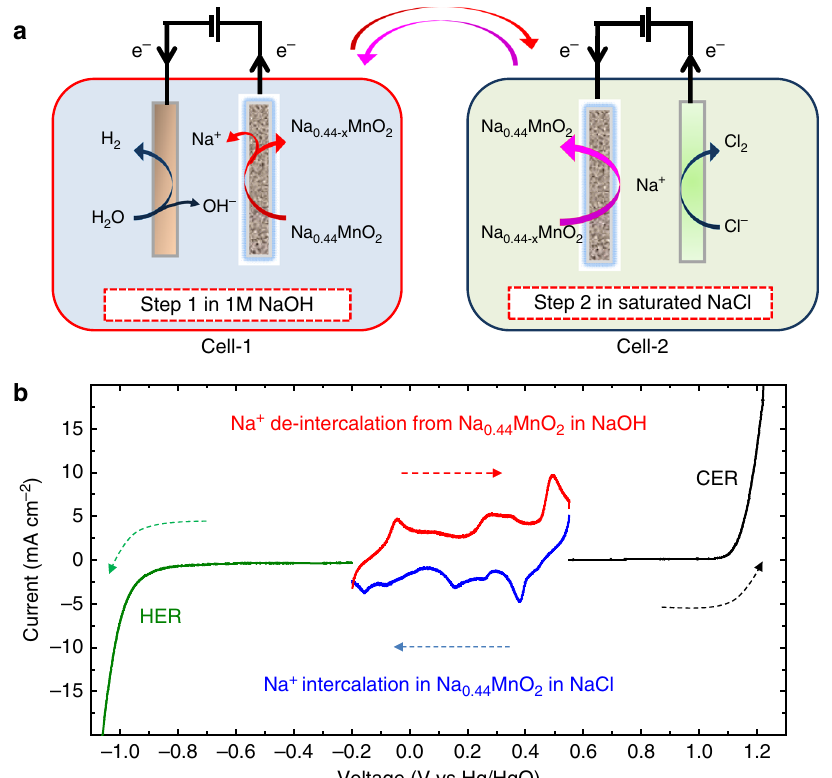
Fig. 1 Mechanism of two-step chlor-alkali electrolysis. a Schematic illustration of the operation mechanism of the electrolysis cell. Step 1 involves the cathodic reduction of H 2 O on the HER electrode and anodic Na + de-intercalation from the Na 0.44 MnO 2 electrode in an NaOH solution (Cell 1); Step 2 depends on the cathodic Na + intercalation on the Na 0.44 − x MnO 2 electrode and anodic Cl 2 evolution reaction on the CER electrode in a saturated NaCl solution (Cell 2). b Linear sweep voltammetric (LSV) data at a sweep rate of 2 mV s − 1 of Na + de-intercalation from Na 0.44 MnO 2 in 1 M NaOH (red line) and Na + intercalation in Na 0.44 − x MnO 2 in a saturated NaCl solution (blue line); LSV data of the commercial Pt-coated Ti-mesh electrode for HER at a sweep rate of 2 mV s − 1 in 1 M NaOH solution (green line); LSV data of commercial RuO 2 /IrO 2 -coated Ti-mesh electrode for CER in a saturated NaCl solution (black line) at a sweep rate of 2 mV s − desodiation in the alkaline electrolyte and those of sodiation in the brine electrolyte is ~0.11 V, which indicates a good reversibility. Furthermore, the special potential window for the Na 0.44 MnO 2 /Na 0.44 − x MnO 2 redox couple is between the onset potentials for the HER and CER (the green and black lines in Fig. 1b, respectively). The result indicates that Na 0.44 MnO 2 can be used as a redox mediator to decouple the conventional chlor- alkali process into two steps, according to Fig. 1a. The galvanostatic charge – discharge curve of the Na 0.44 MnO 2 elec- trode at a current density of 0.1 A g − 1 is shown in Supplementary Fig. 8 to clarify the speci fi c capacity of Na 0.44 MnO 2 .